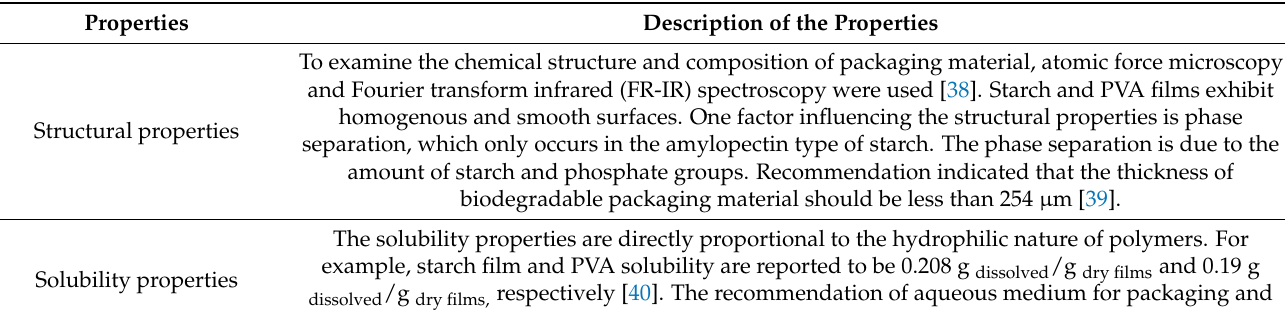
Table 3. Properties of starch-based biodegradable films for food